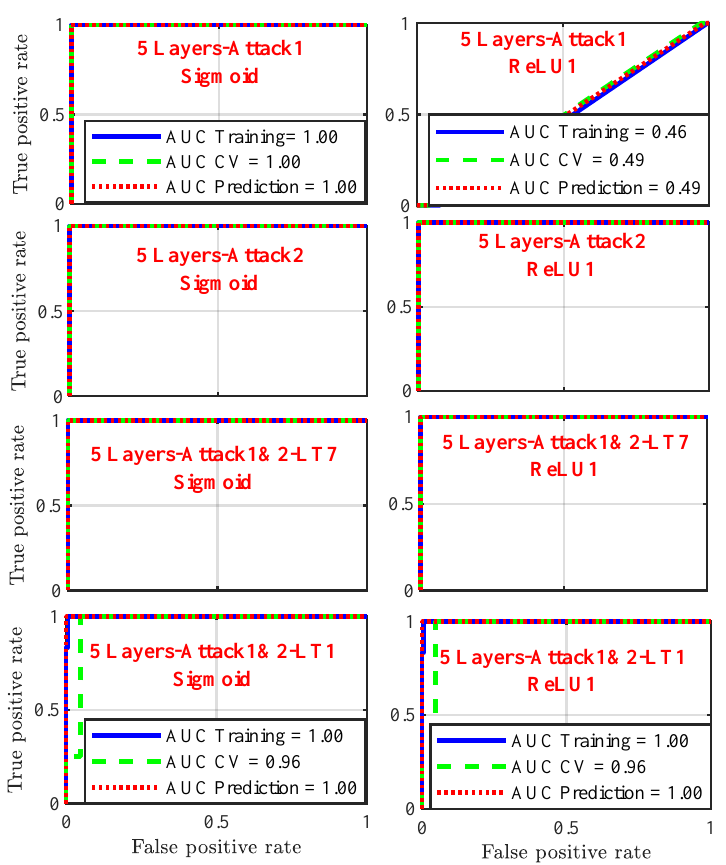
Figure 7. The ROC of various attack scenarios without any measurement noise, using the 5-layer DNN detection